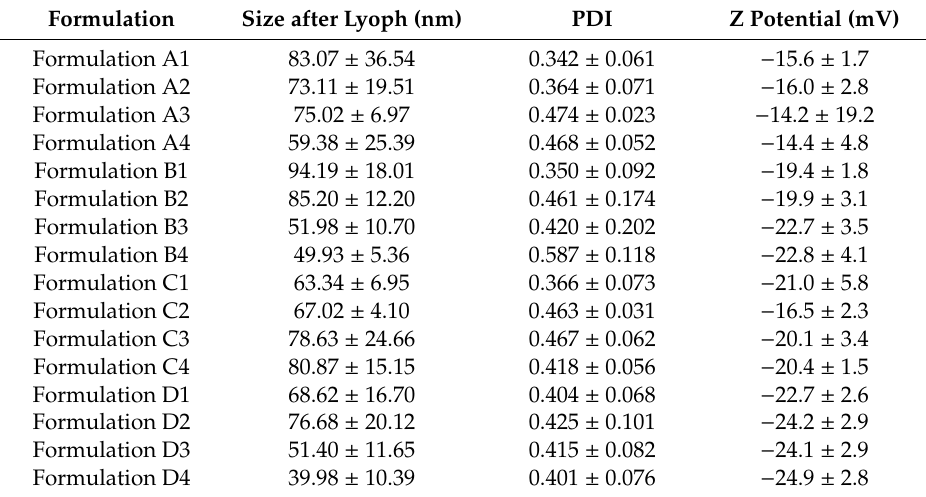
Table 2. Characterization of the developed NLCs ( n = 3 for all the nanoformulations). The data are presented in media ± SD.